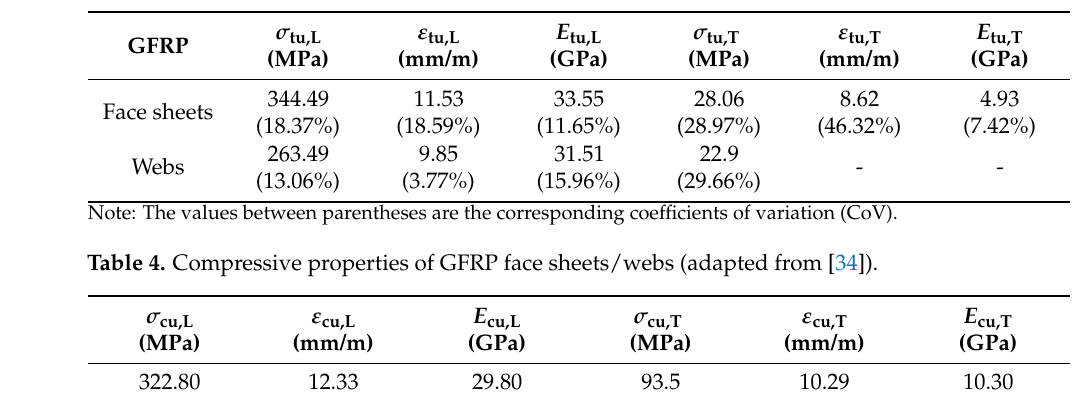
Table 3. Tensile properties of the GFRP face sheets/webs.